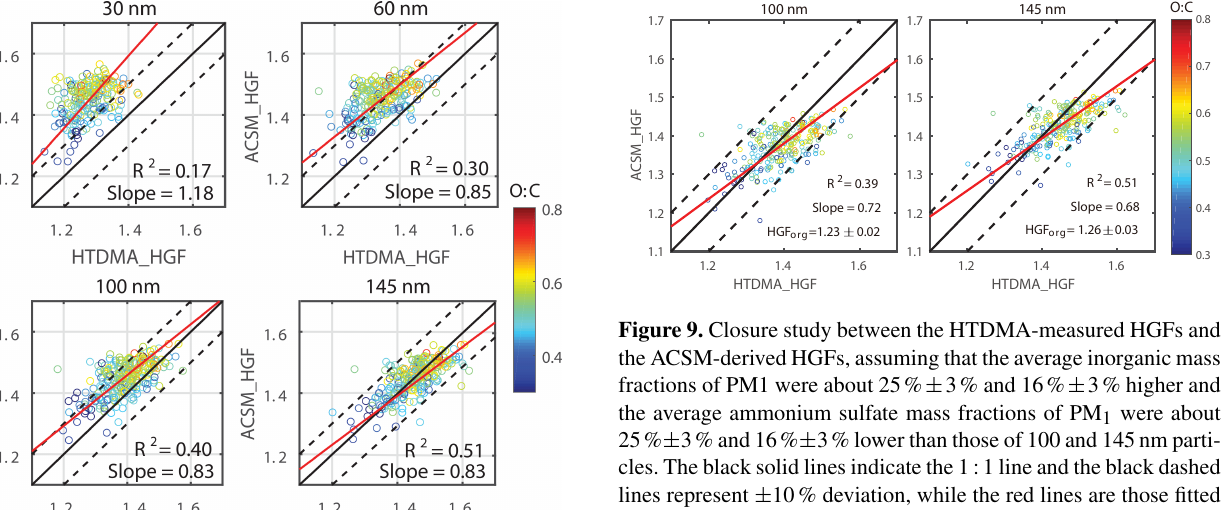
Figure 9. Closure study between the HTDMA-measured HGFs and the ACSM-derived HGFs, assuming that the average inorganic mass fractions of PM1 were about 25% ± 3% and 16% ± 3% higher and the average ammonium sulfate mass fractions of PM 1 were about 25% ± 3% and 16% ± 3% lower than those of 100 and 145nm parti- cles. The black solid lines indicate the 1:1 line and the black dashed lines represent ± 10% deviation, while the red lines are those fitted to the data points. The color bar indicates the O : C ratio of the or- ganic aerosol